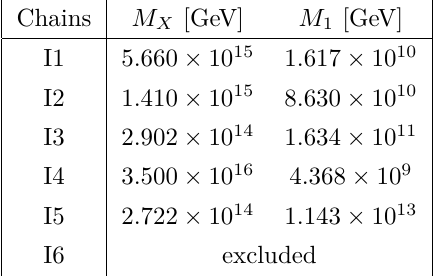
Table 3 . Predictions of the GUT scale, M X , and the lowest intermediate scale, M 1 , in breaking chains with a single intermediate scale. Chain I6 is excluded as no solution for the gauge unification